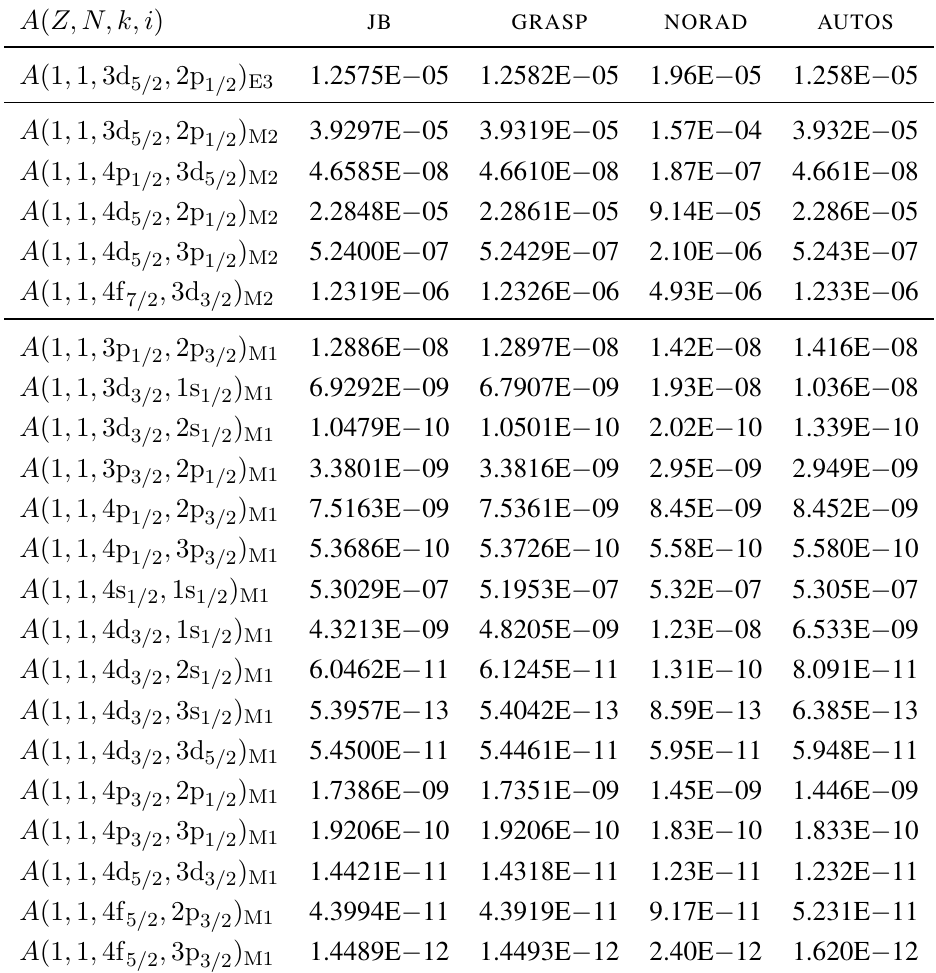
Table 2. Problematic A -values (s − 1 ) for E3, M2 and M1 forbidden transitions in H I . JB : standard reference [100,101]. GRASP : computed with GRASP [98]. NORAD : computed with SUPERSTRUCTURE [96] and listed in the NORAD database. AUTOS : computed